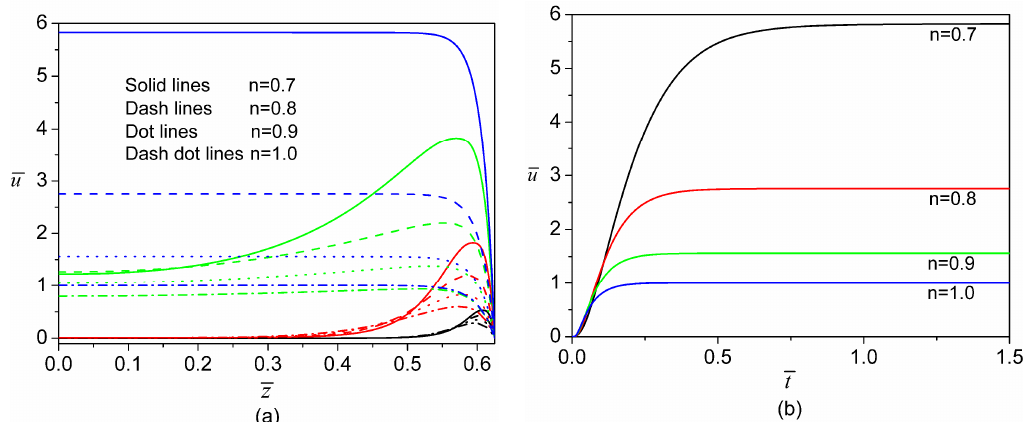
Figure 4. Comparison of transient development of electroosmosis for four different fluid behavior indices ( n = 0.7, 0.8, 0.9 and 1.0) when E 0 = 1 and ψ w = − 1. ( a ) Transient velocity profiles along z axis at y = 0. There are four groups of velocity profiles in this plot and each group represents the velocity profiles of four flow behavior indices at a specific time instant: the group with black color is at t = 10 − 3 , the group with red color is at t = 10 − 2 , the group with green color is at t = 10 − 1 and the group with blue color is at the steady state ( t → ∞ ); ( b ) Time evolution of velocity at the center of cross-section ( z = y =